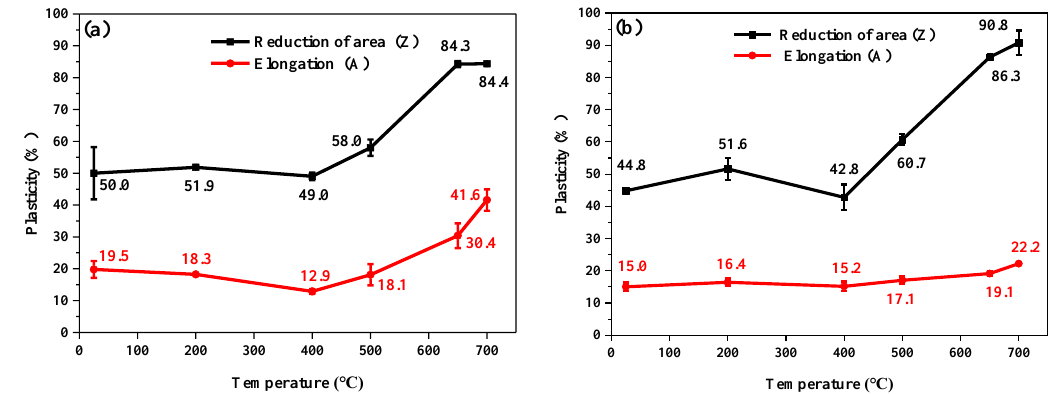
Figure 4. Relationship between temperature and plasticity of heat-resistant steel at different temperatures: ( a ) 9Cr–1.5Mo–1Co and ( b ) 9Cr–3W–3Co.